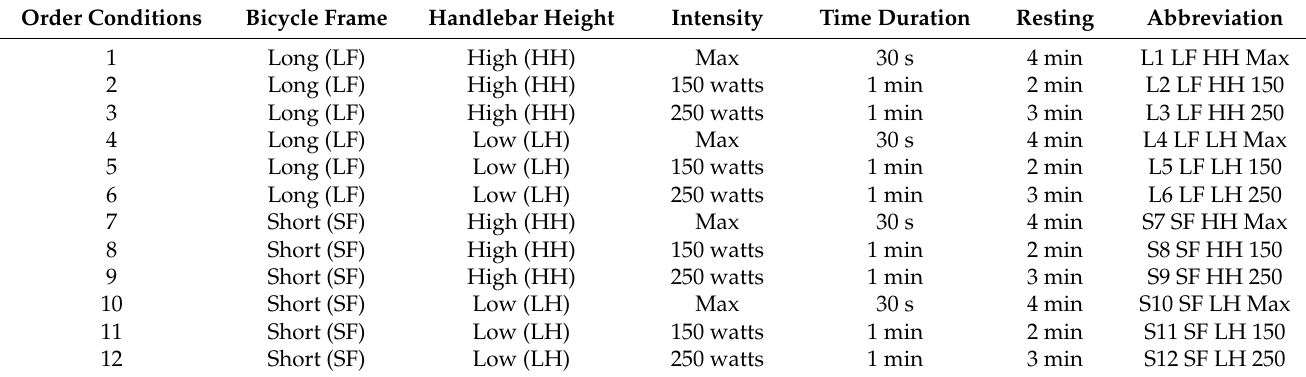
Table 1. Test session protocol in twelve different cycling conditions.